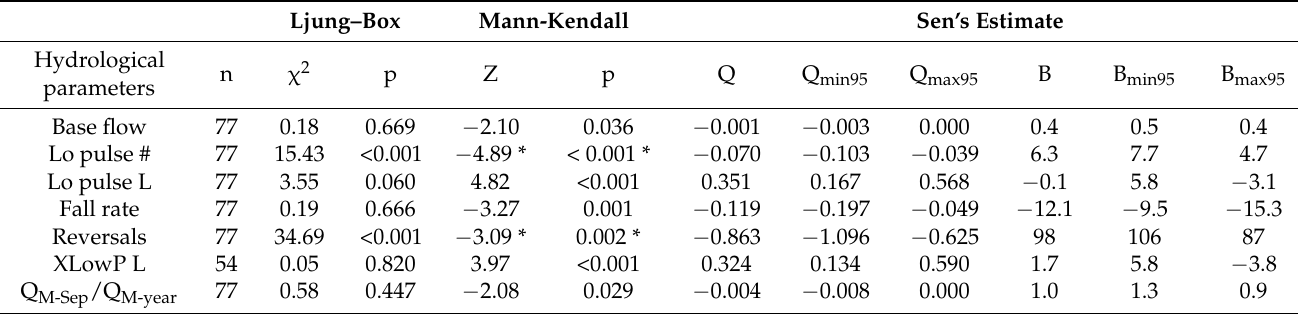
Table 1. Statistics of Ljung–Box, Mann-Kendall test (or its modified version [32]*), and Sen’s method for the significant trends of the hydrological parameters concerning the Lake Maggiore outflows recorded during the period 1943–2019 (see Figure 2). Base flow = 7-day minimum flow divided by mean annual flow, Lo pulse # = number of annual low pulses, Lo pulse L = median duration of low pulses (days), Fall rate = median of all negative differences between consecutive daily values, Reversals = number of hydrologic reversals, XLowP L = median duration of extreme low-flow periods (days), Q M-Sep /Q M-year = mean flow of September divided by mean annual flow, n = the number of annual values in the calculation, χ 2 = statistic of Ljung–Box test, Z = statistic of the Mann-Kendall test, p = significance level, Q = the Sen’s estimator for the true slope of linear trend, B = estimate of the constant B in the Sen’s equation, min95 and max95 = limits of the 95% confidence